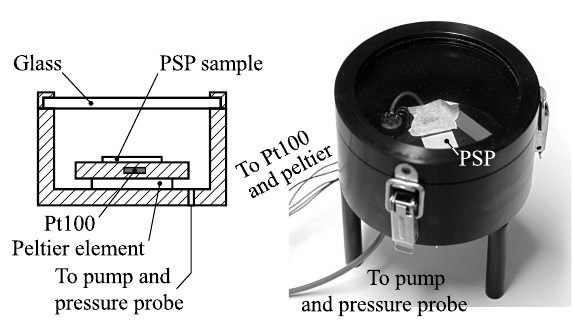
Figure 9. Calibration chamber.